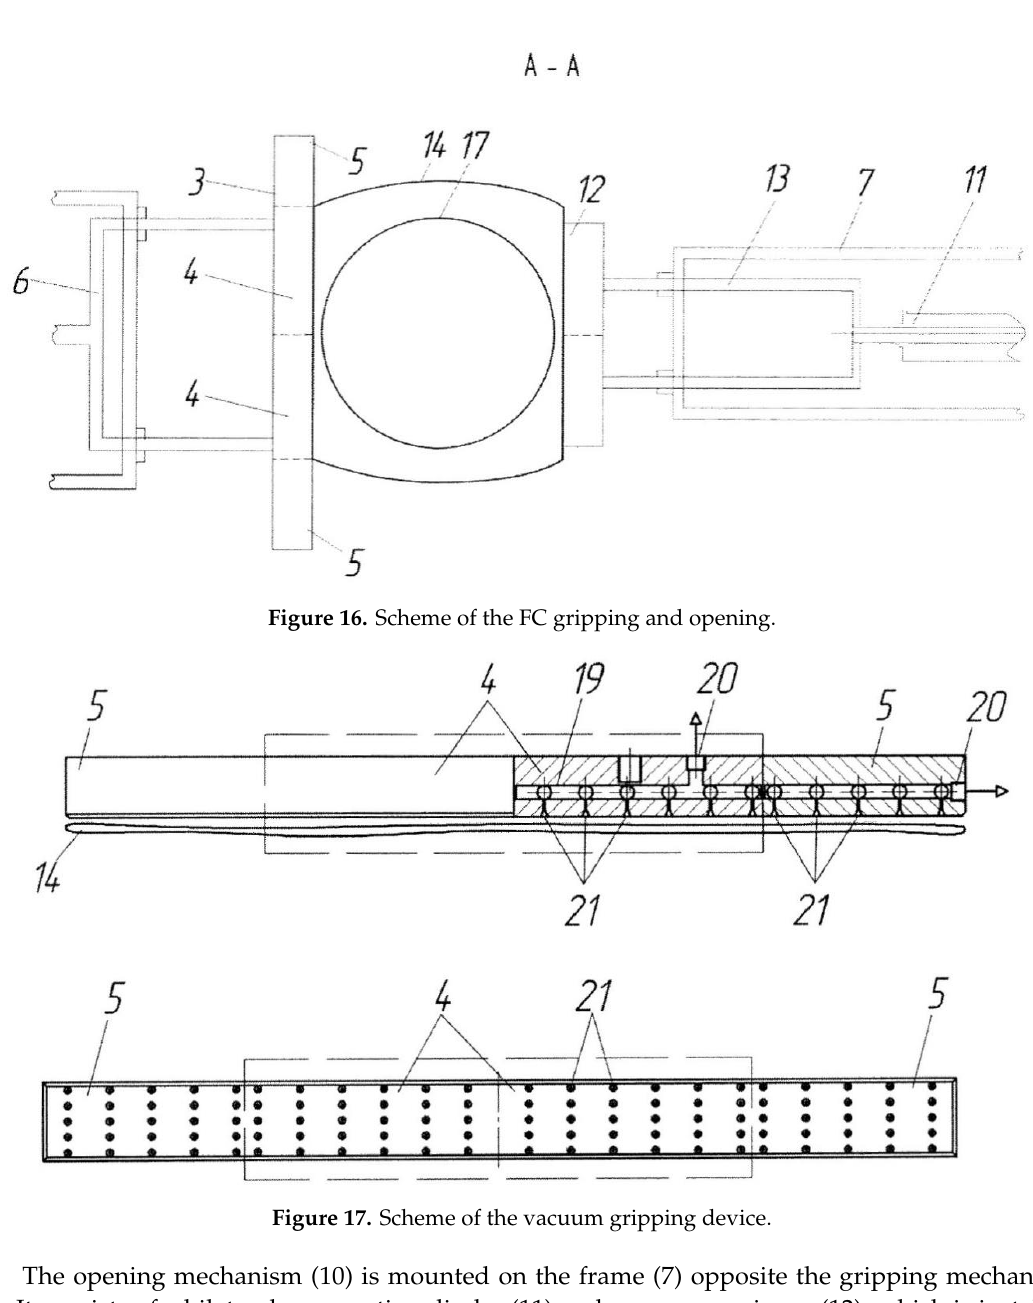
Figure 15. Scheme of the unit for automatic packaging of bulk materials.